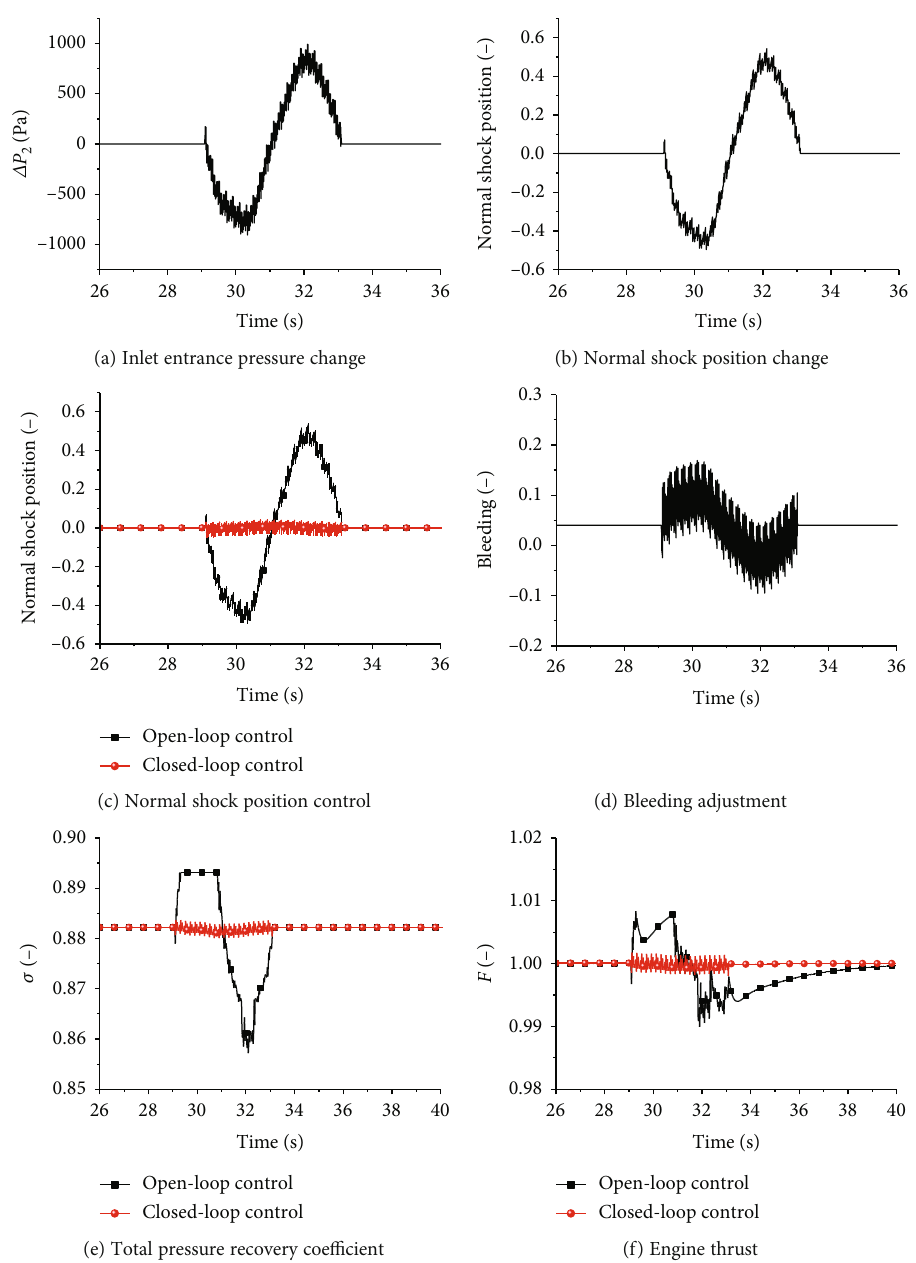
Figure 16: Simulation results of di ff erent operating